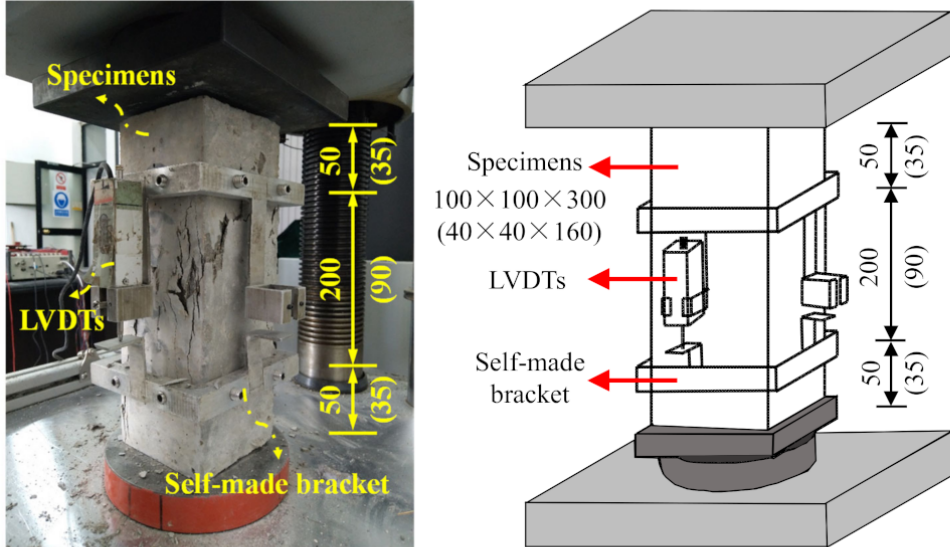
Figure 2. Diagram of test equipment (unit: